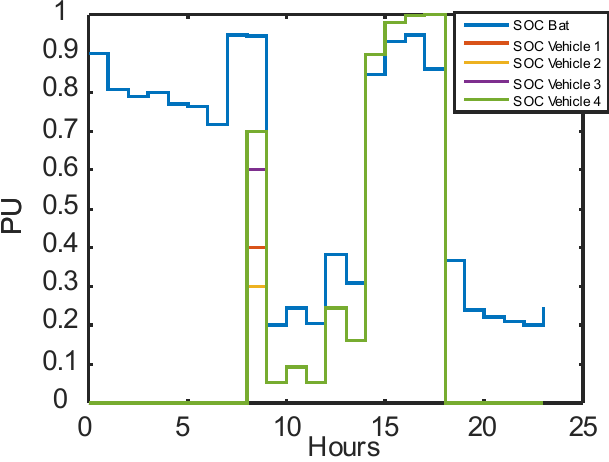
Figure 10. SOC of battery and Park of EV (PEV) for a clear summer day.